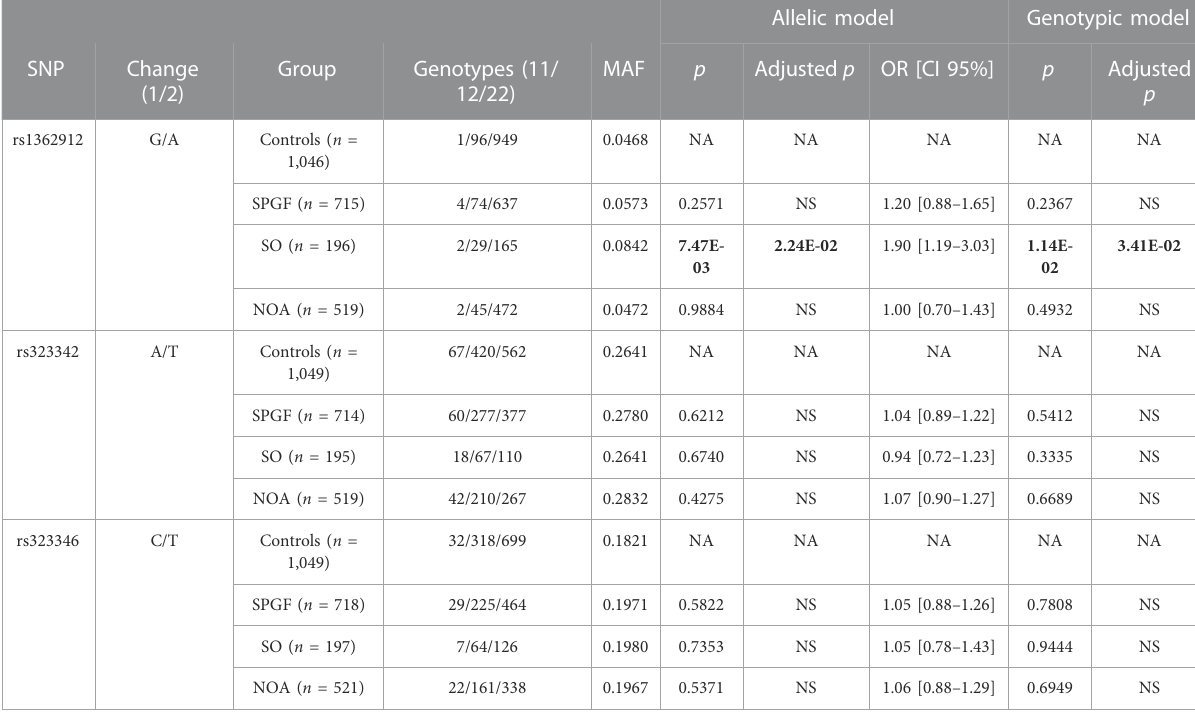
TABLE 1 Analysis of the genotype and allele frequencies of the TEX15 tagger variants comparing groups of male infertility against the unaffected control